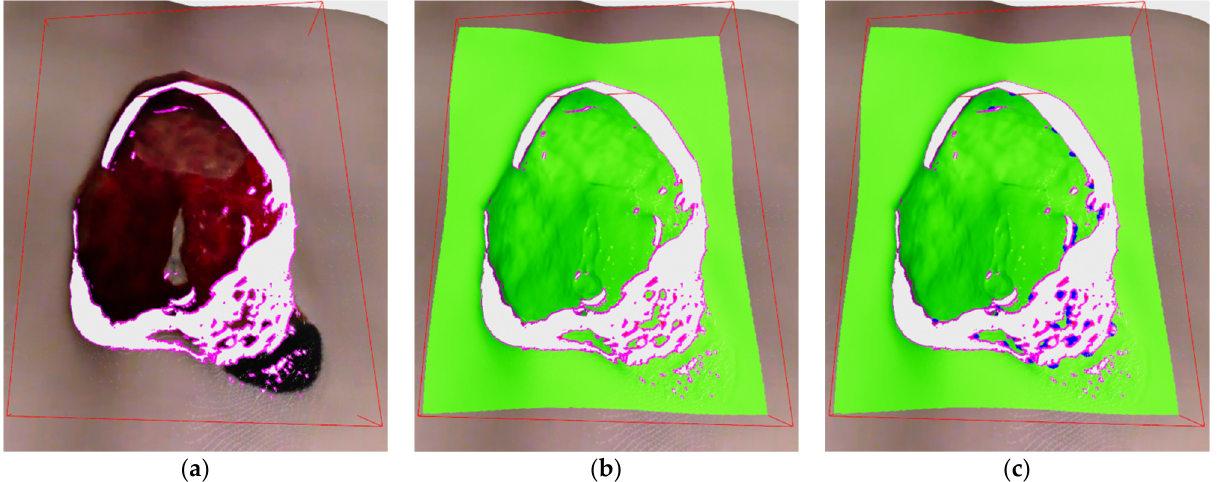
Figure 8. ( a ) Classified edge points in magenta color; ( b ) classified core and outlier points in green and red color; ( c ) classified frontier points in blue color. Algorithm 2. Algorithm for Classifying Points into: Core, Outlier and Frontier